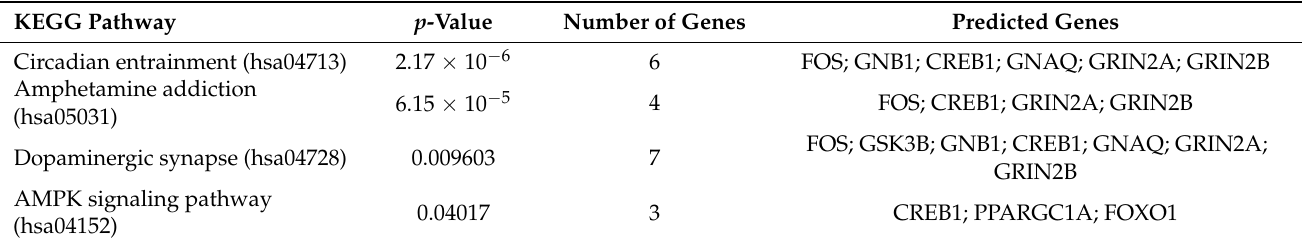
Table 6. The target genes of miRNAs with lower expression in the nonresponder cohort (hsa-mir-5586, hsa-mir-642a, hsa-mir-101, hsa-mir-632) predicted by DIANA-mirPath. KEGG Pathway p -Value Number of Genes Predicted Genes Circadian entrainment (hsa04713) 2.17 × 10 − 6